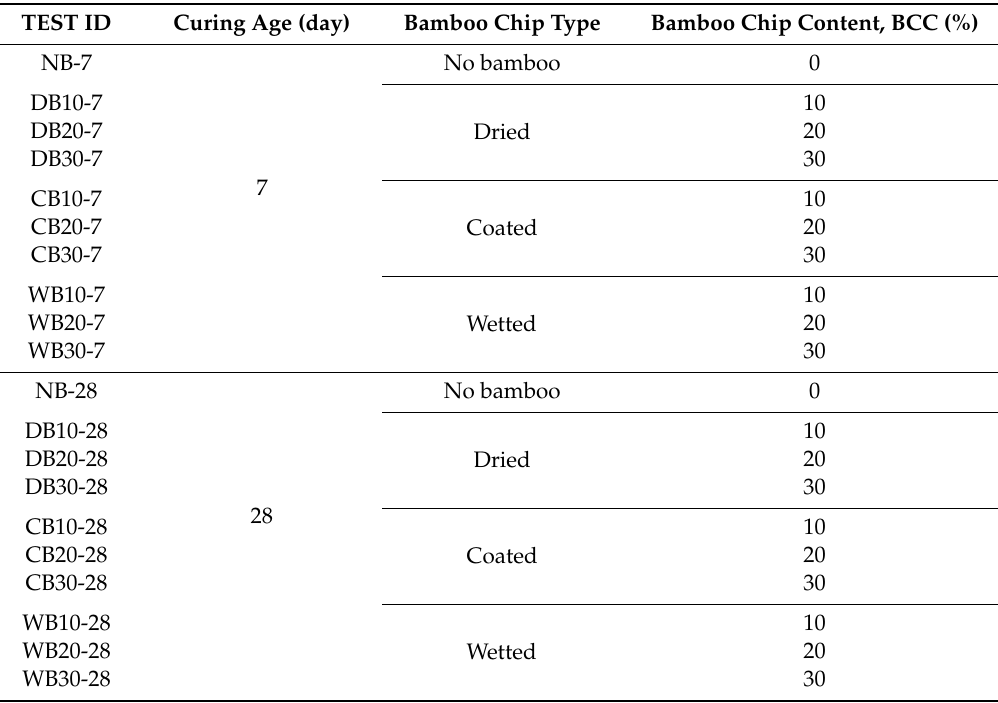
Table 2. Summary of concrete specimen with bamboo chips.